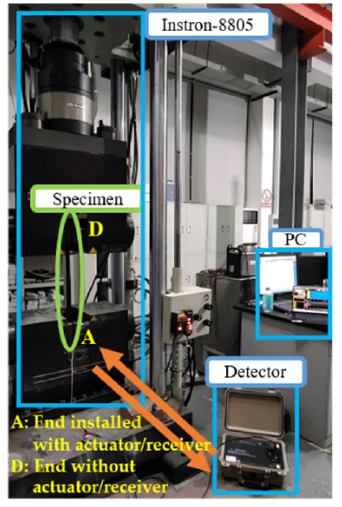
Figure 21. Photograph of experimental setup.